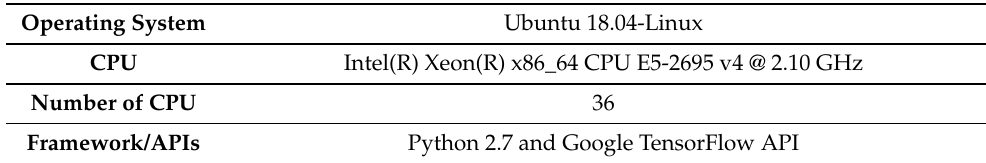
Table 7. Experiments A.1-2 Environment Setup Details.